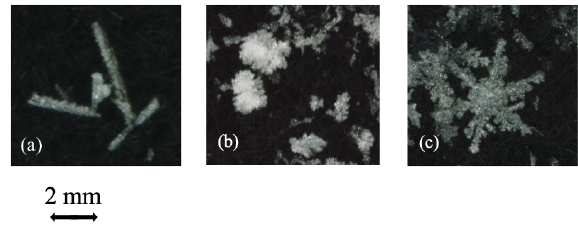
Figure 7. Microphotography from FMP showing the changes in snow crystal type during the 4–5 May 2019 storm. (a) Needles ob- served at 23:55UTC 4 May 2019, (b) graupel and rimed irregular particles observed at 01:21UTC 5 May 2019, and (c) rimed den- drites and branches observed at 09:56UTC 5 May 2019. Double arrow length indicates 2mm for